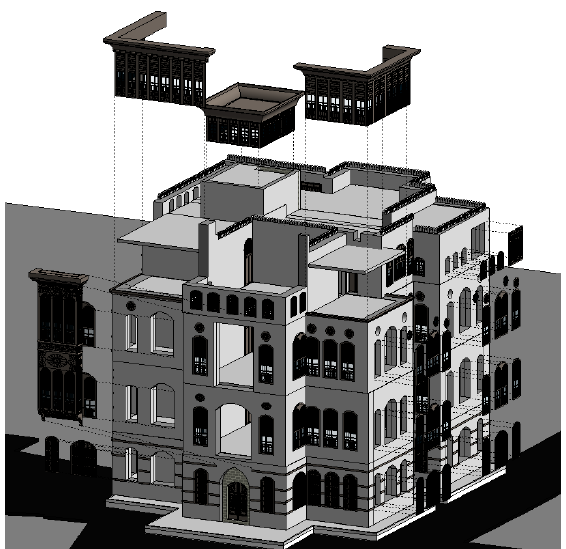
Figure 18. Inserting the HAOL into the JHBIM model of